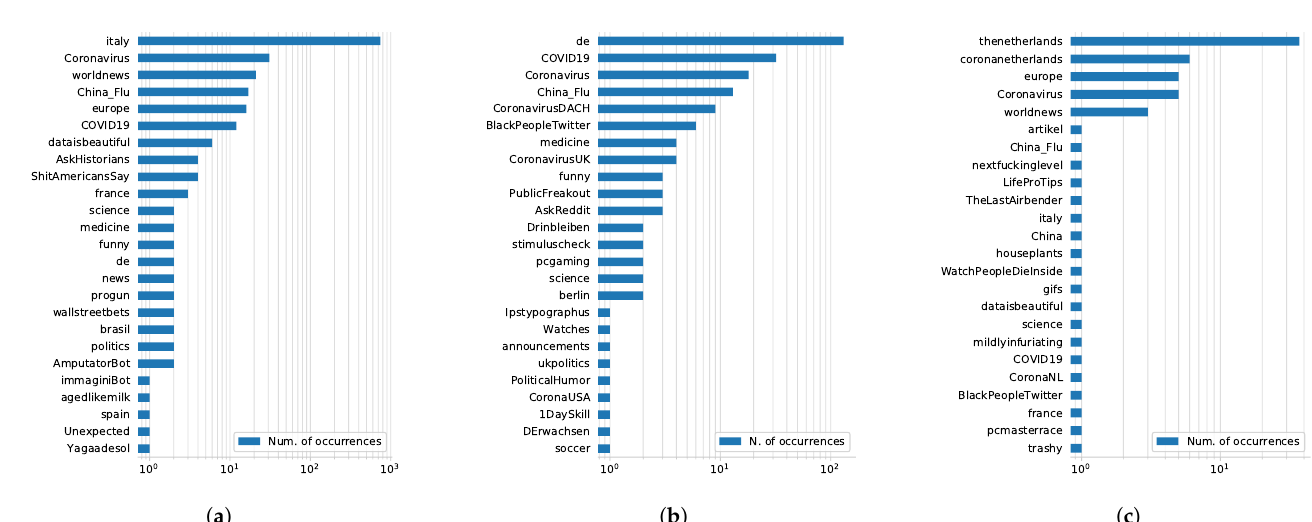
Figure 13. The top 25 most linked subreddits in ( a ) /r/italy, ( b ) /r/de and ( c ) /r/thenetherlands.